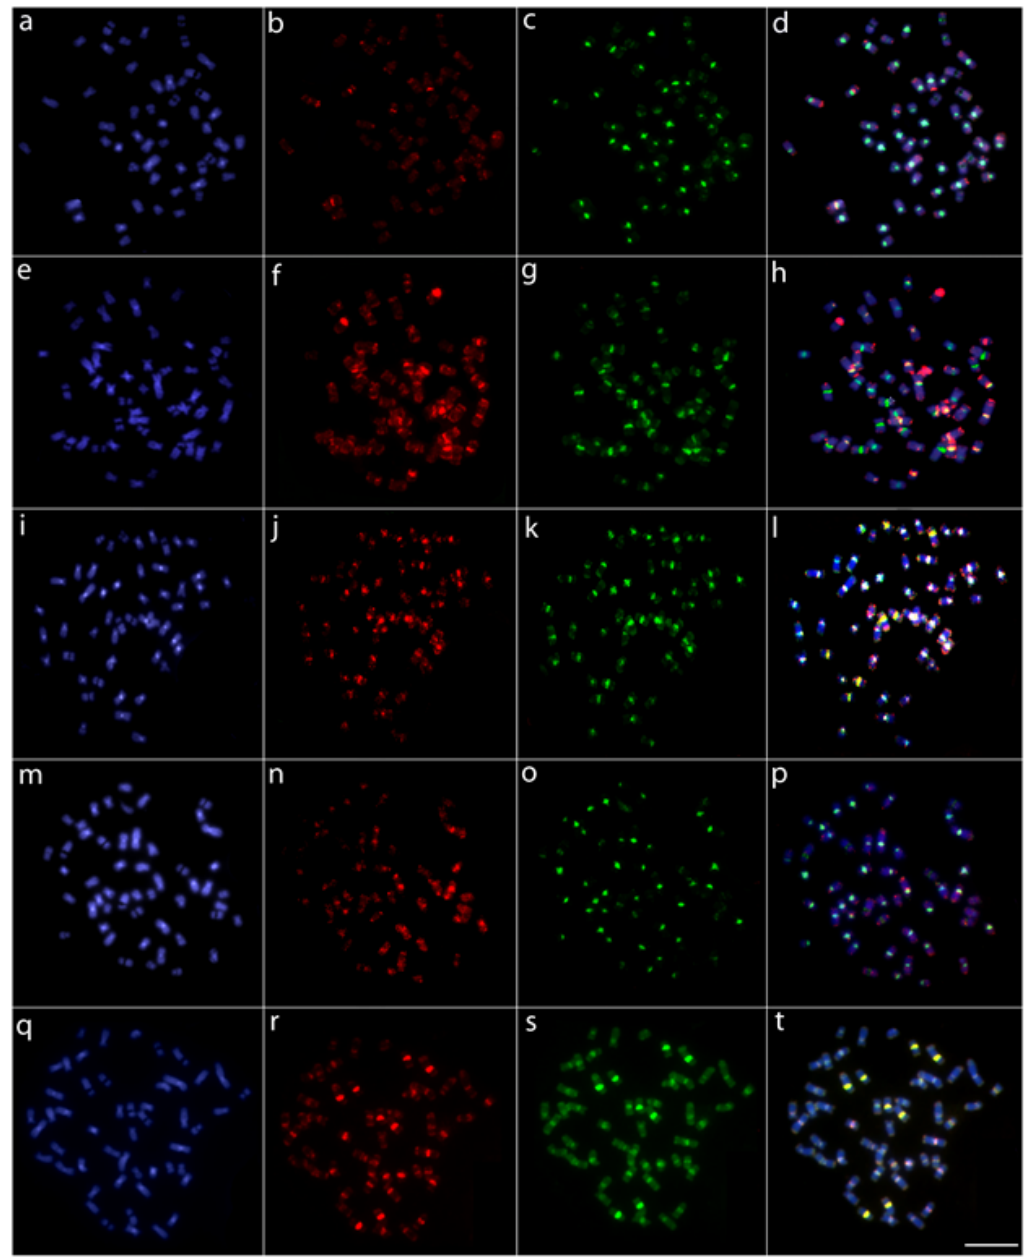
Figure 4. Comparative genomic hybridization using the gDNA of the five Hoplias species against the chromosomal background of H. intermedius . The first column ( a , e , i , m , q ): DAPI images (blue); second column ( b , f , j , n , r ): hybridization patterns using gDNA probe from H. intermedius ; third column ( c , g , k , o , s ): hybridization patterns using gDNA probes from H. aimara , H. australis , H. brasiliensis , H. curupira , and H. lacerdae , respectively; fourth column ( d , h , l , p , t ): merged images of both genomic probes and DAPI staining depicting the shared regions in yellow. Scale bar = 5 µ